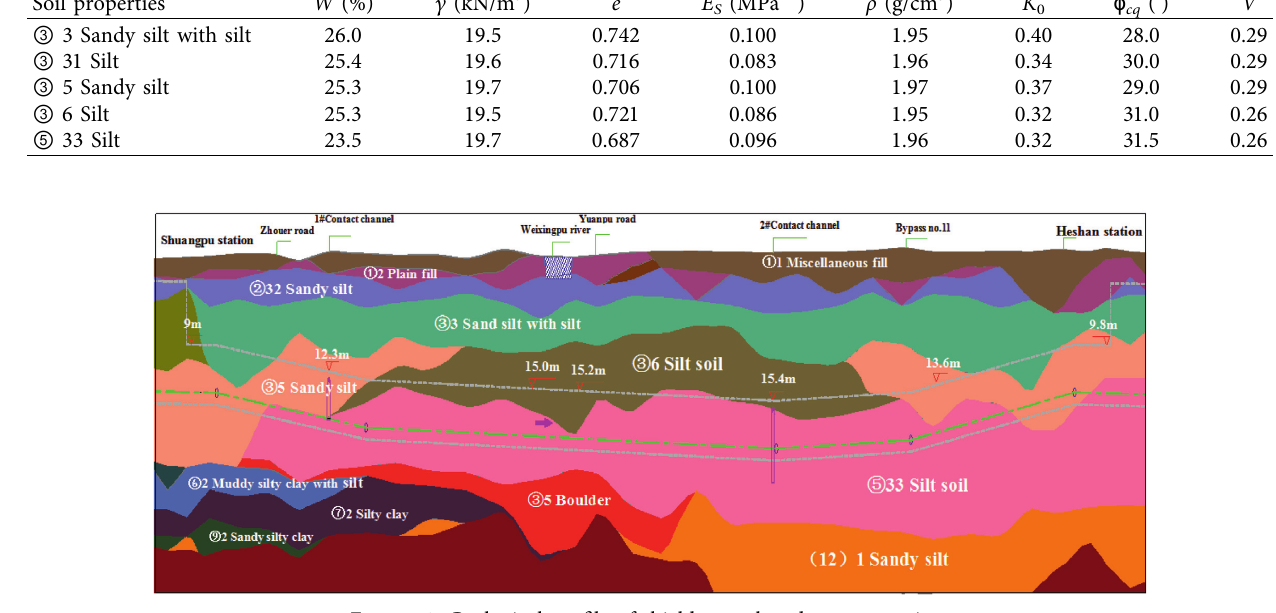
Figure 1: Geological profile of shield tunnel under construction.